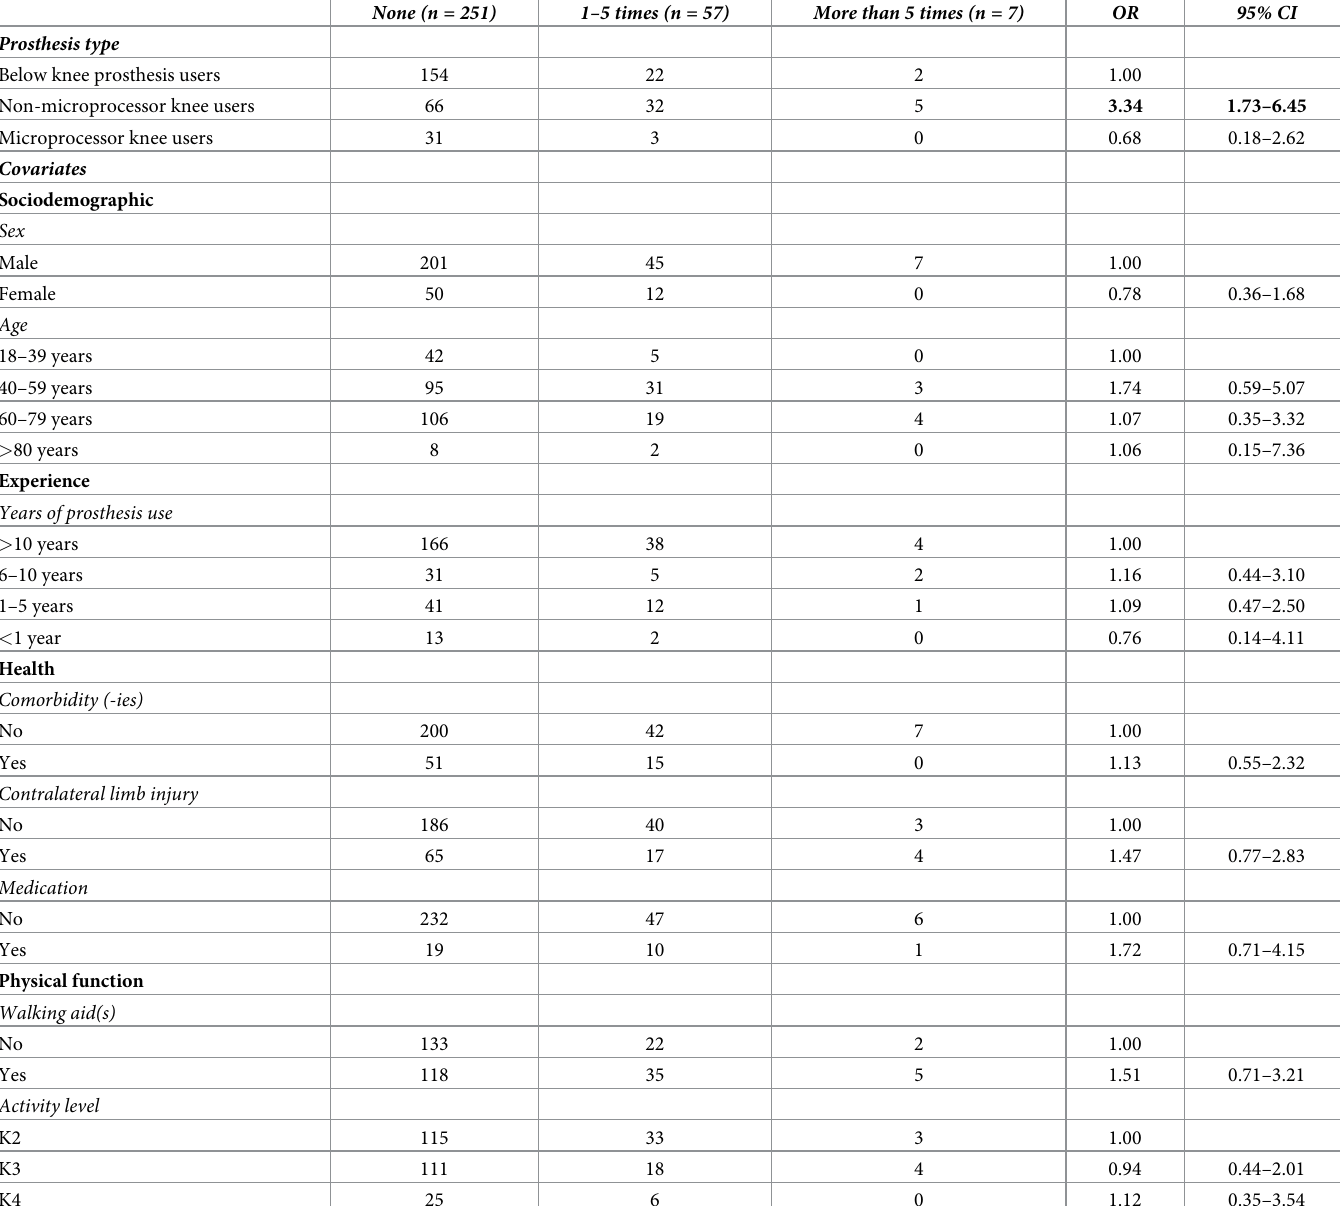
Table 2. The frequency of falls by prosthesis type and each of the covariates. Odds ratios (OR) and 95% Confidence Intervals (CI) are shown; bold text indicates statisti- cally significant observations. None (n = 251) 1–5 times (n =